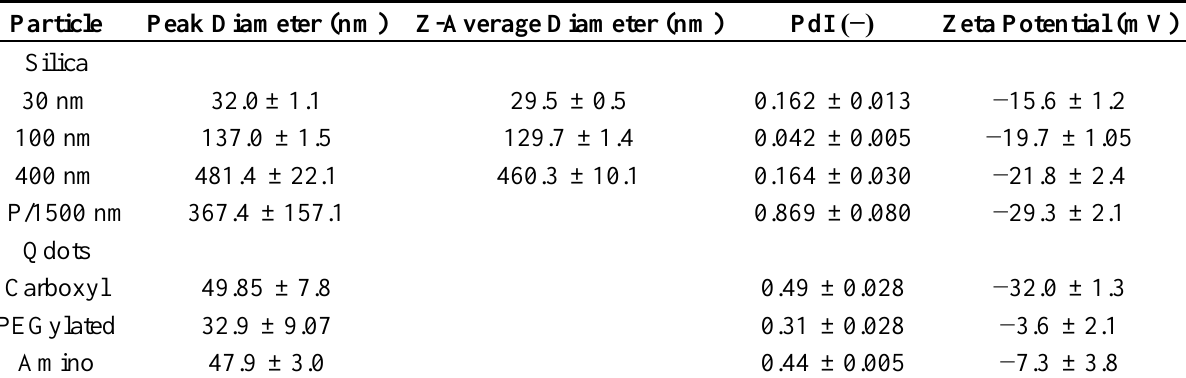
Table 3. Characterization of